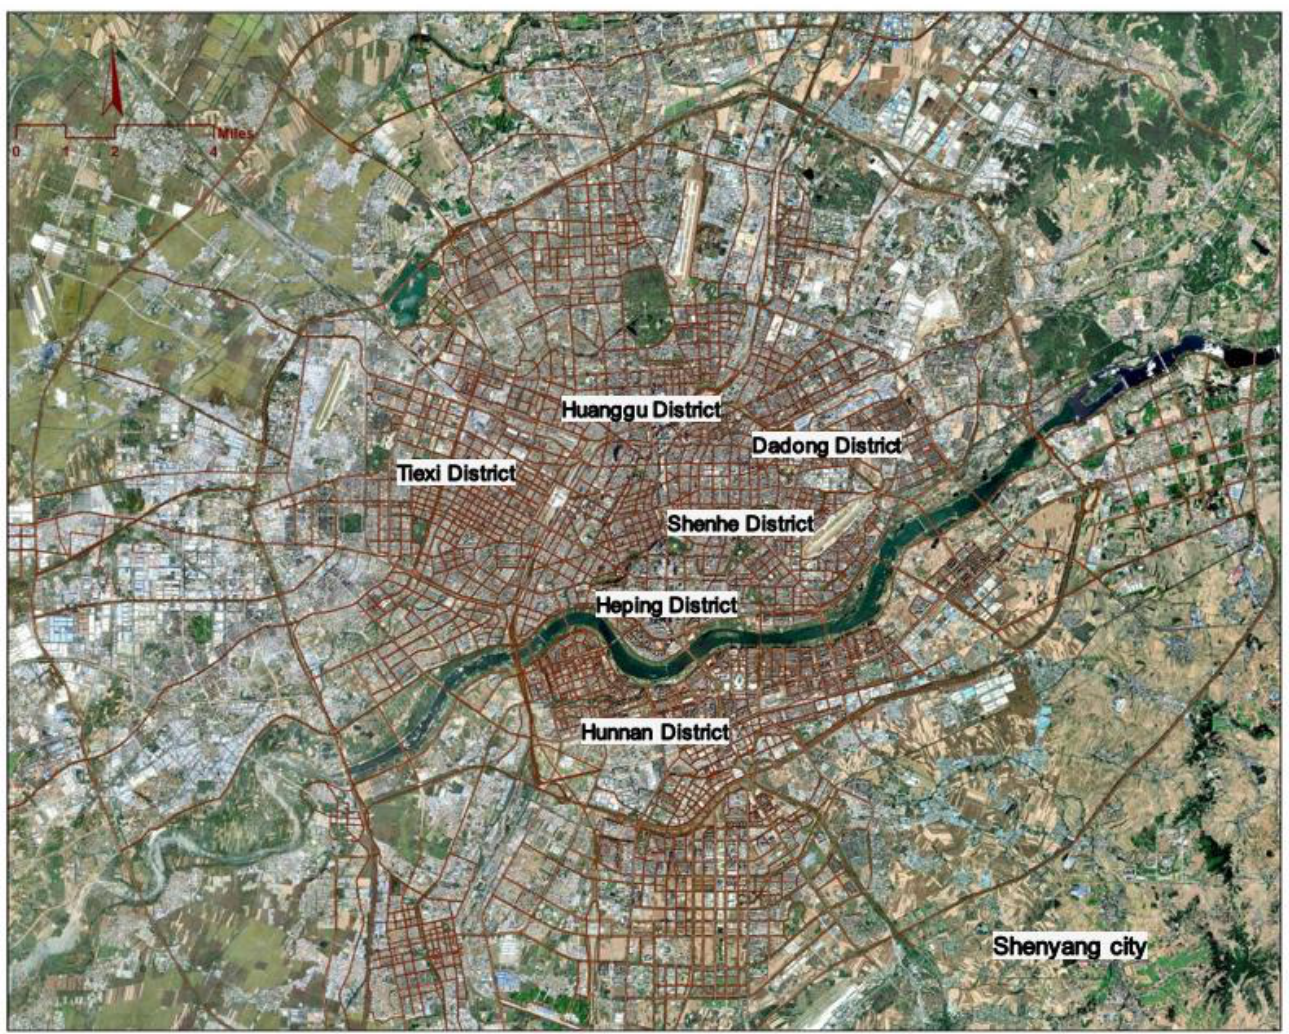
Figure 1. Shenyang city satellite map. Source: Google Maps.